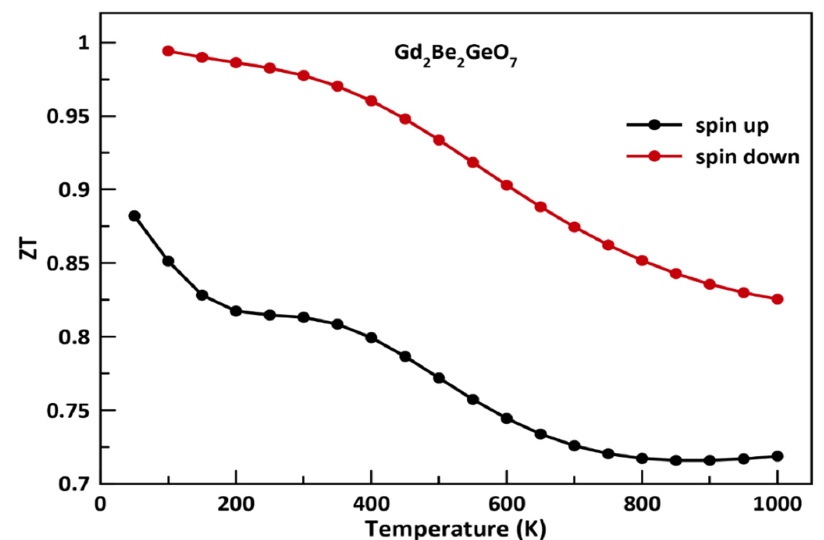
Figure 15. Figure of merit (ZT) for Gd 2 Be 2 GeO 7 compound as a function of temperature in both spin channels (up and down).